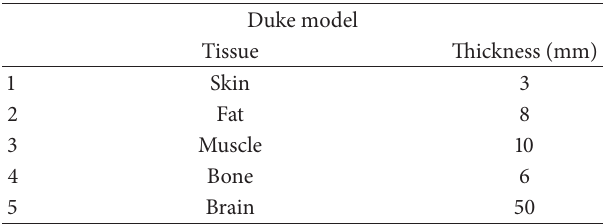
Table 2: Tissues and corresponding thicknesses of a section of the head of the Duke model.